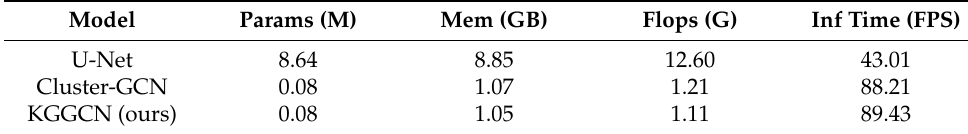
Table 3. The performance and system resource requirements of three networks. Model